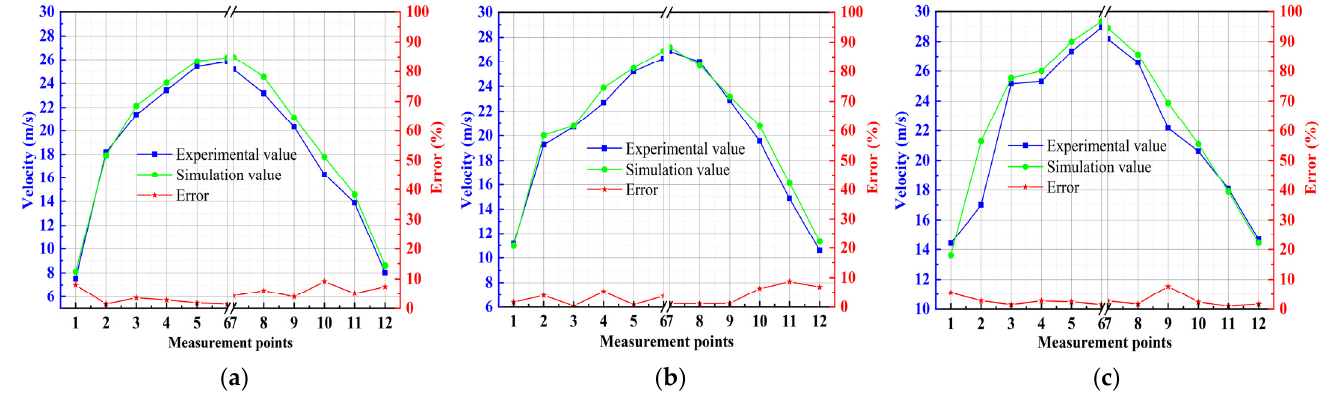
Figure 17. Comparison between simulation and test of inlet air velocity at different negative pres- sures: ( a ) comparison of inlet air velocity at 2400 Pa; ( b ) comparison of inlet air speed at 2800 Pa; ( c ) comparison of inlet air speed at 3200 Pa.